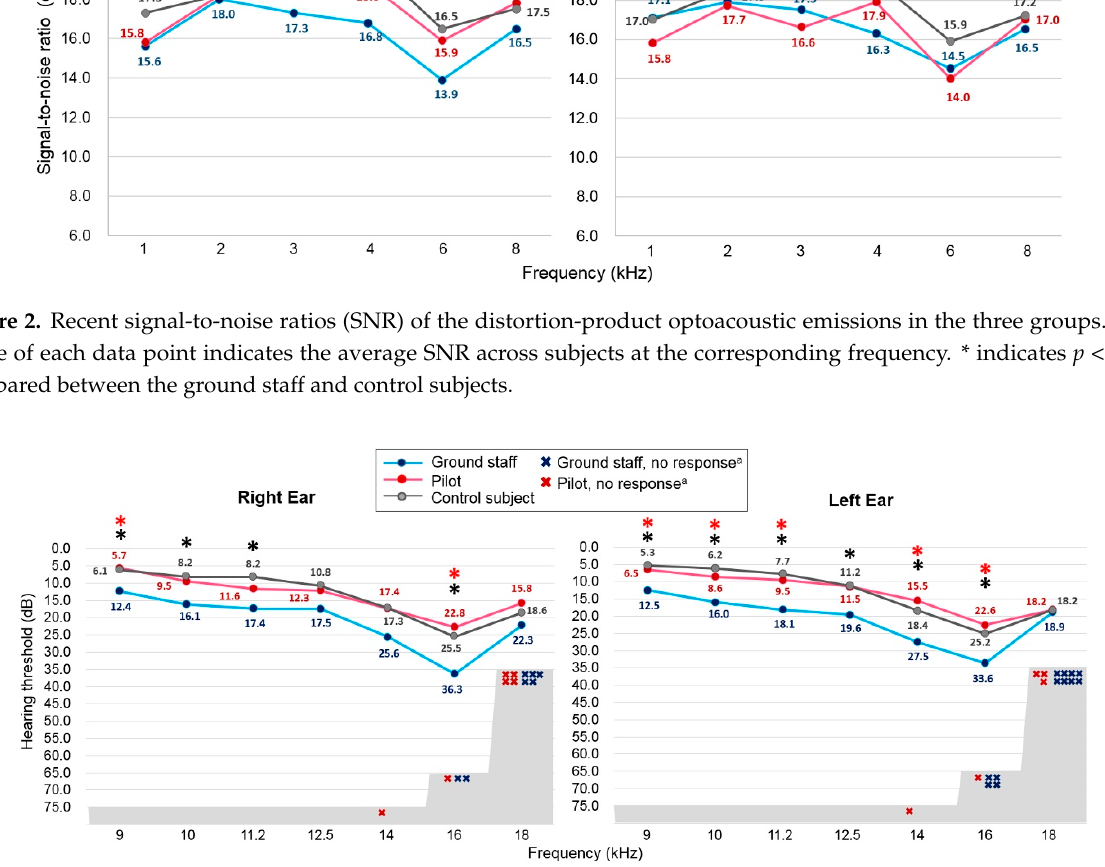
Figure 2. Recent signal-to-noise ratios (SNR) of the distortion-product optoacoustic emissions in the three groups. The value of each data point indicates the average SNR across subjects at the corresponding frequency. * indicates p < 0.05, compared between the ground staff and control subjects .